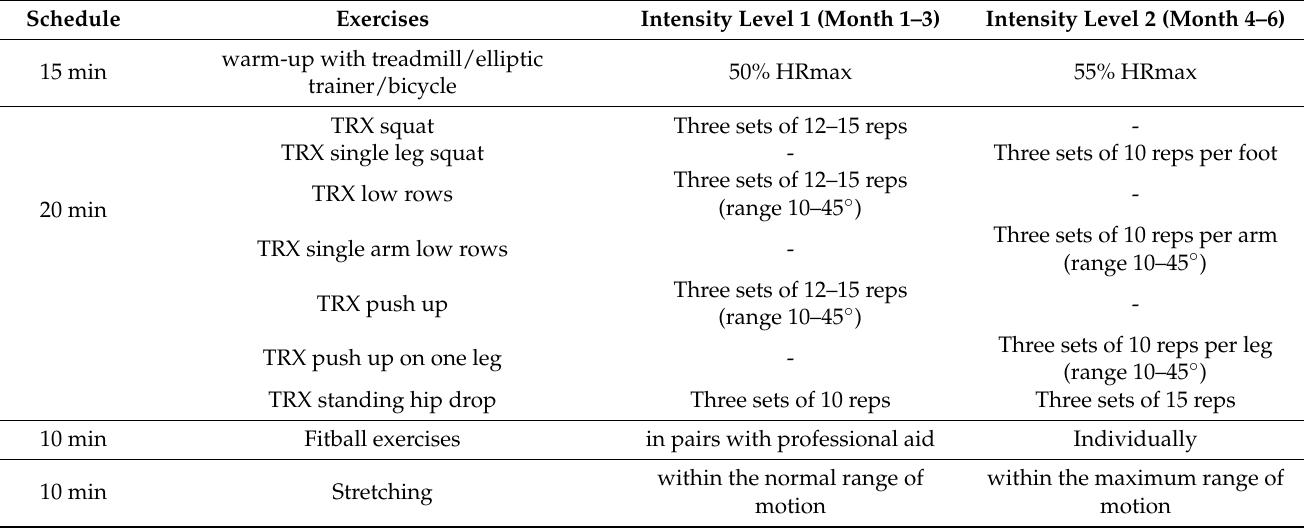
Table 1. Training protocol (HRmax = maximal heart